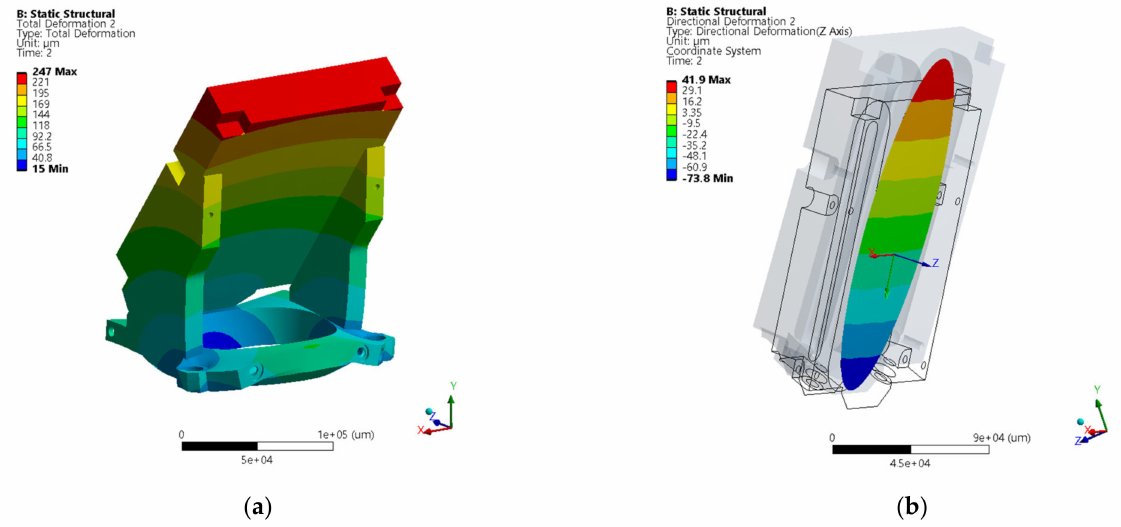
Figure 11. ( a ) Total deformation of mirror and bracket; ( b ) normal deformation of the optical surface.